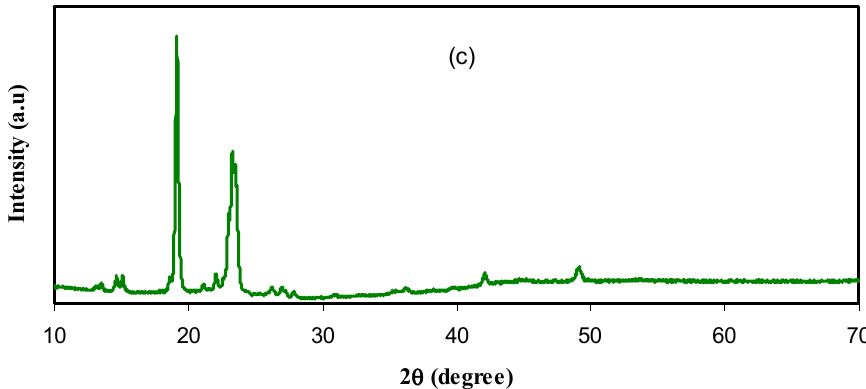
Figure 1. Powder X-ray diffraction (XRD) patterns for the ( a ) pure PEO (PEPN0), ( b ) PEO:CNDs (PEPN1), and ( c ) PEO:CNDs:Ag (PEPN2) samples.